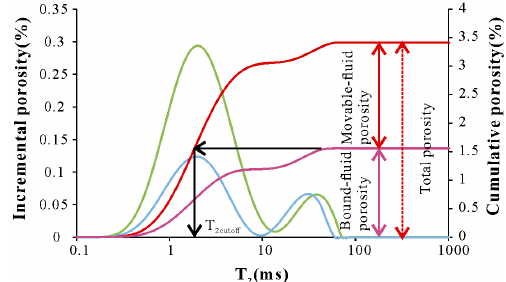
Figure 6. The cumulative and incremental T 2 spectrum of sample 5.